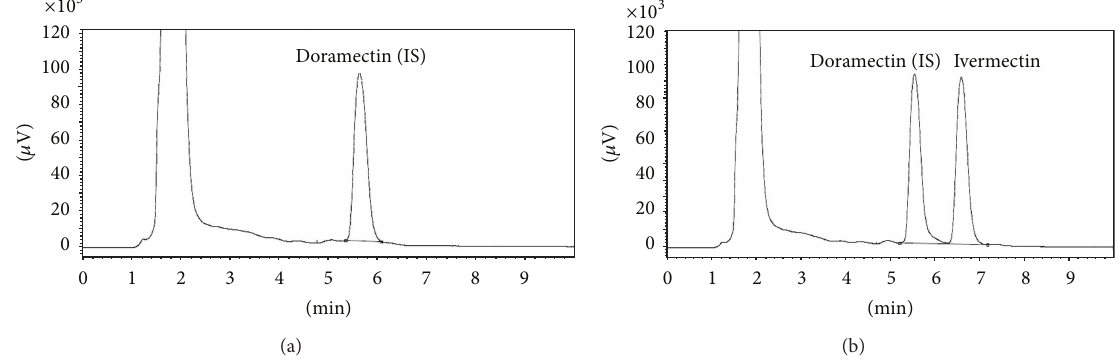
Figure 1: Chromatograms of blank feed (a) and feed fortified with ivermectin at concentration of 2mg kg −1